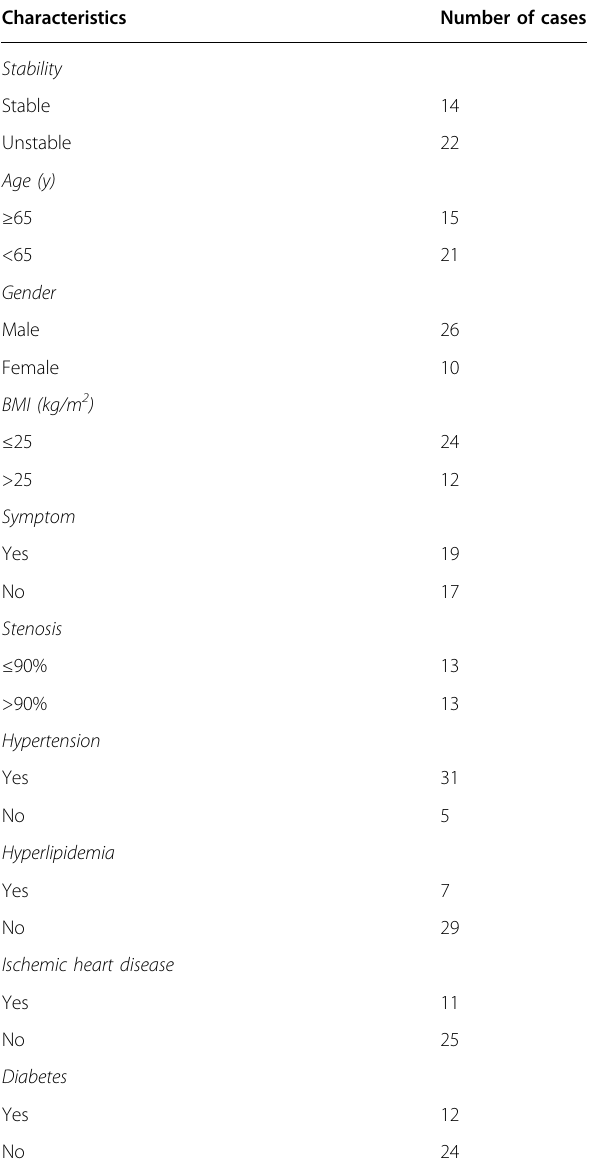
Table 1 Characteristics carotid AS